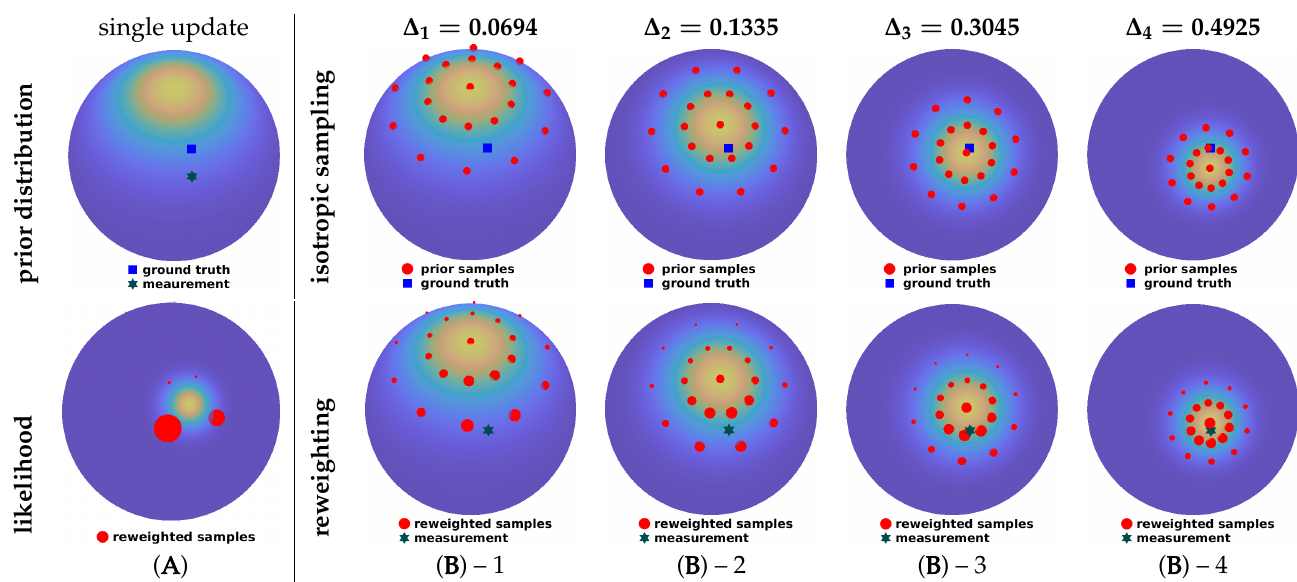
Figure 3. Illustration of the deterministic progressive update using isotropic sample sets. Sizes of red dots are proportional to their weights. The same isotropic sampling configuration, ( λ , τ ) = ( 2, 10 ) , is deployed for both the single-step and the progressive updates.